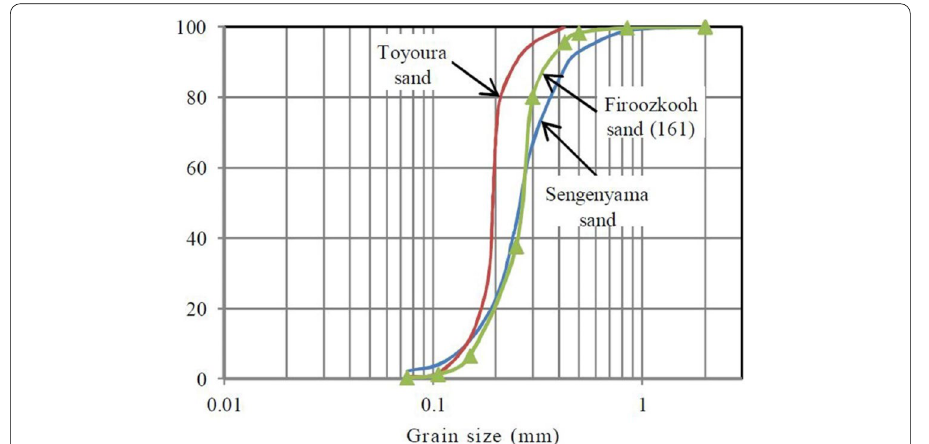
Fig. 5 Particle size distribution of Firoozkooh 161 sand compared with Toyoura and Sengenyama sand